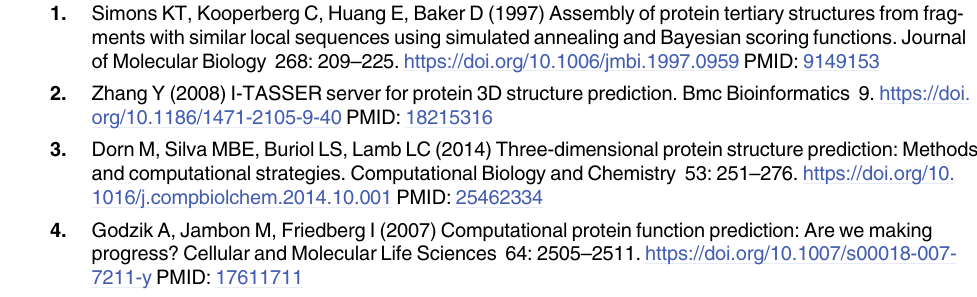
S14 Fig. The accuracy achieved by a random forest of 60 artificial neural networks obtained with HHBlits-PSSM and training and testing sets that share decreasing levels of sequence identities. (TIF) S15 Fig. The influence of reference dataset size on the SOV3 accuracy of SSP. (TIF) S1 File. The TS416 dataset.